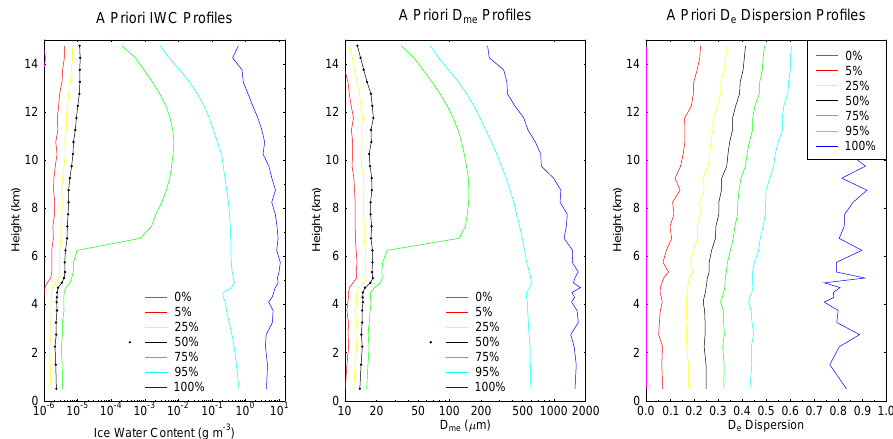
Fig. 4. Profiles of IWC, D me , and D e dispersion from seven percentiles in the a priori cumulative distribution functions. Below the freezing level, the profiles are applied to the melting/melted particles instead of the ice particles.